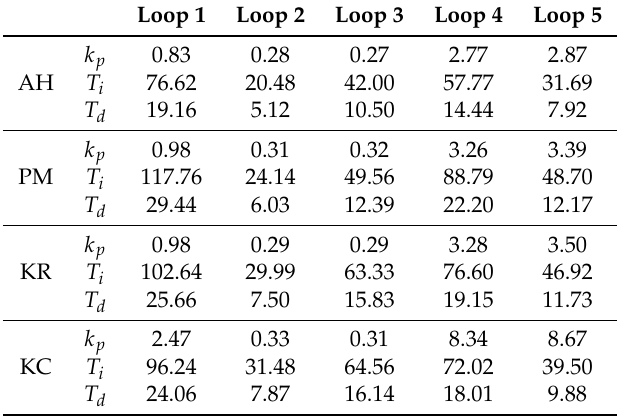
Table 4. PID parameters with different autotuners for steam/water